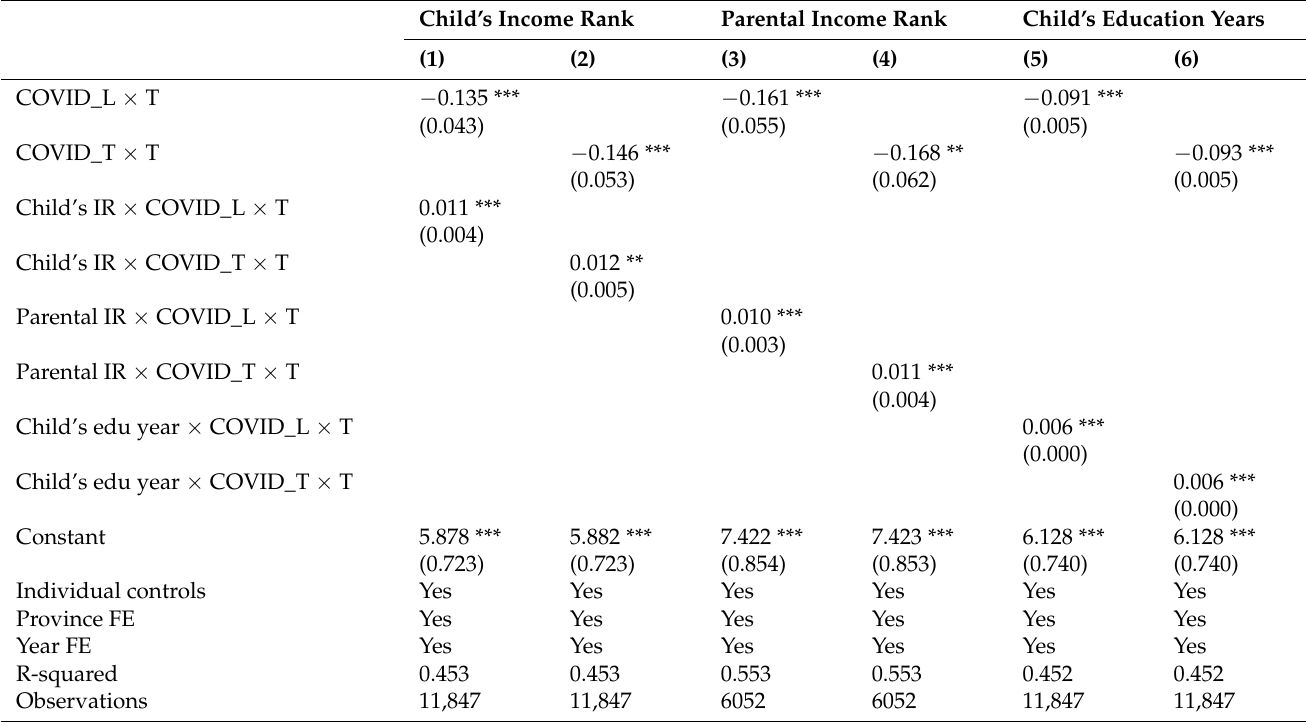
Table 5. The effects of COVID-19 on the income of different